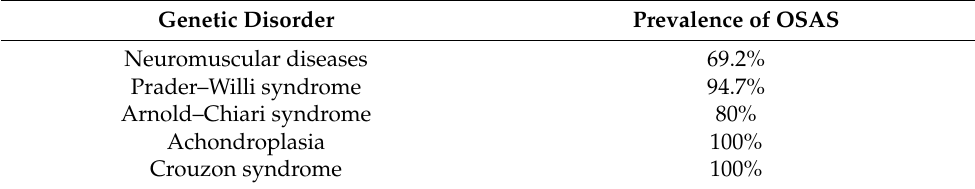
Table 2. Prevalence of